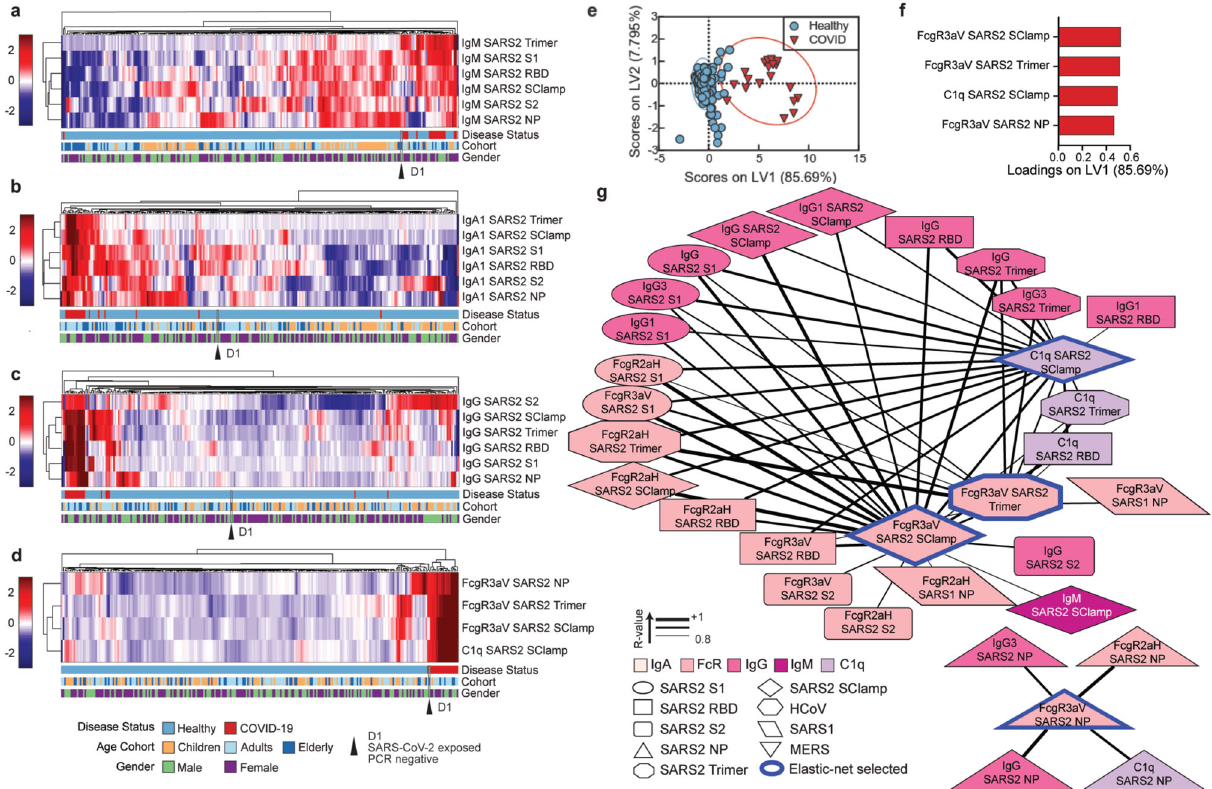
Fig. 4 Healthy versus COVID-19 serological signatures. Hierarchical clustering of all SARS-CoV-2 antigens for IgM ( a ), IgA1 ( b ) and IgG ( c ). Levels are coloured from low (dark blue) to high (dark red). Hierarchical clustering ( d ) and PLSDA model scores ( e ) and loadings ( f ) were performed using the four- feature Elastic-Net-selected SARS-CoV-2 antigen signature (98.51% calibration accuracy, 98.51% cross-validation accuracy). Variance explained by each LV is in parentheses. g Correlation network analysis for COVID-19 patients was performed to identify features signi fi cantly associated with the Elastic-Net- selected features (blue outline). Coded by Ab feature type (colour), antigen (shape) and correlation coef fi cient (line thickness). Data were z -scored prior to analysis. Multiplex assays were repeated in